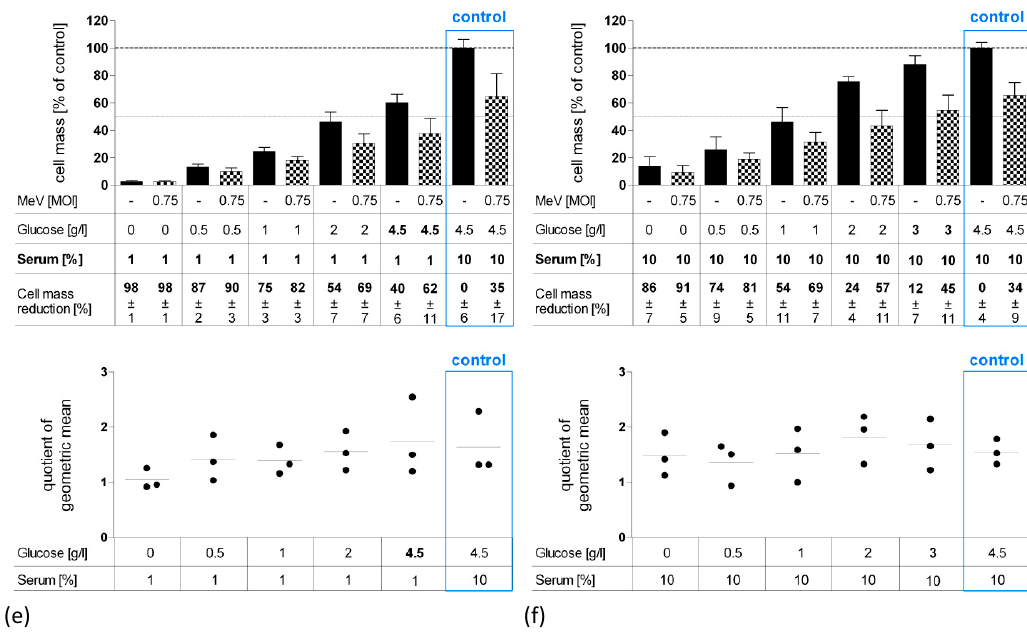
Figure 4. E ff ect of long-term starvation (120 h) on MeV-mediated oncolysis in HT-29 ( a , b ), HCT-15 ( c , d ) and HCT-116 ( e , f ) cells. Long-term starvation of HT-29, HCT-15 and HCT-116 cells was performed according to Figure 1b. On day 1, medium was changed to low-glucose, low-serum medium ( a , c , e ) or low-glucose, standard serum medium ( b , d , f ). At 96 hpi, remaining tumor cell masses were determined by SRB assay. Di ff erences were considered significant when P -values were < 0.05 (*) or < 0.01 (**). Di ff erences in glucose and serum concentrations are pointed out in bold face.